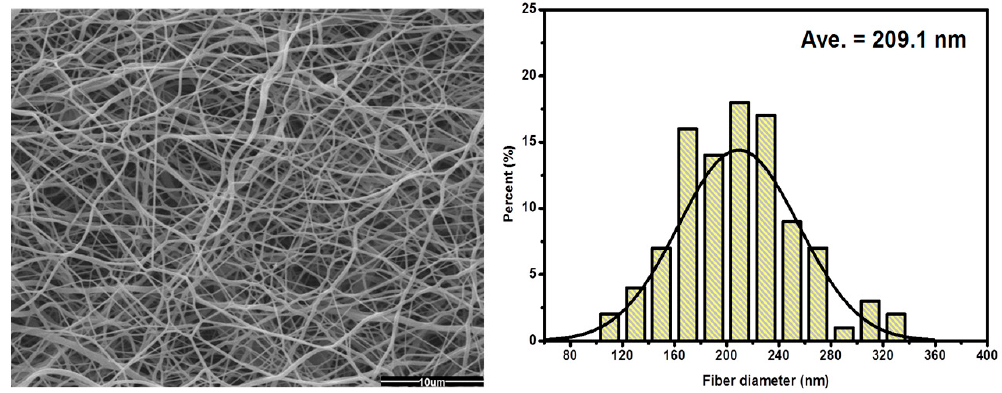
Figure 8. SEM micrograph and diameter distribution of PI nanofibers imidized from PAA nanofibers prepared at the optimal solution blow spinning (SBS) parameters.